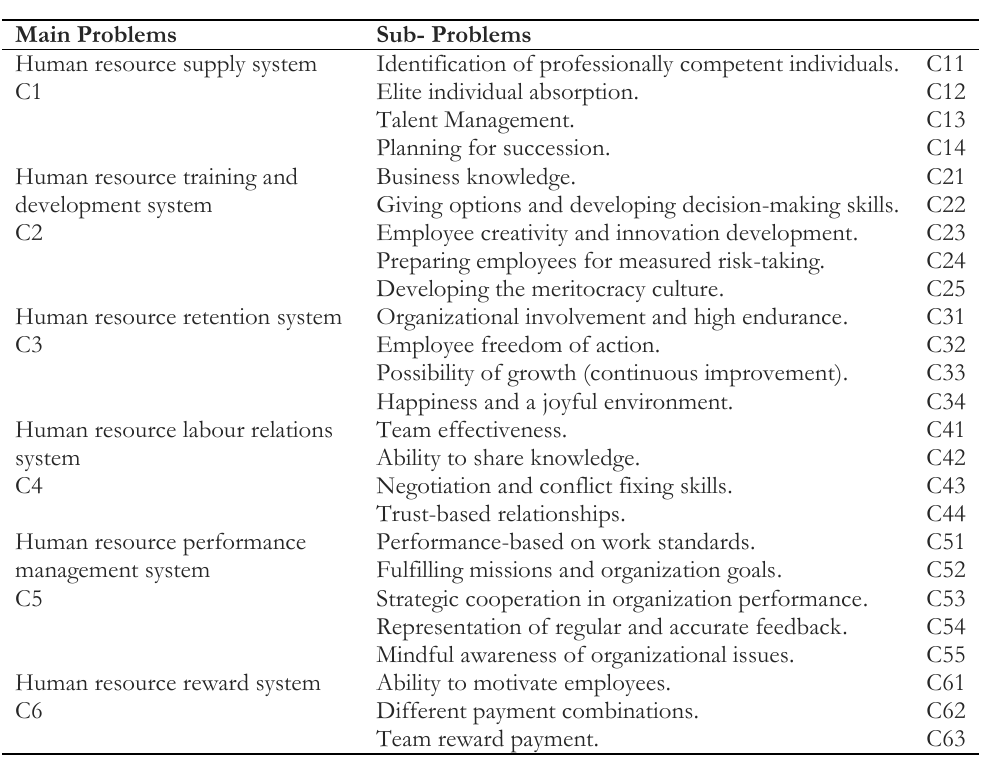
Table 3. The damages for the human resource management system based on international and global competencies.